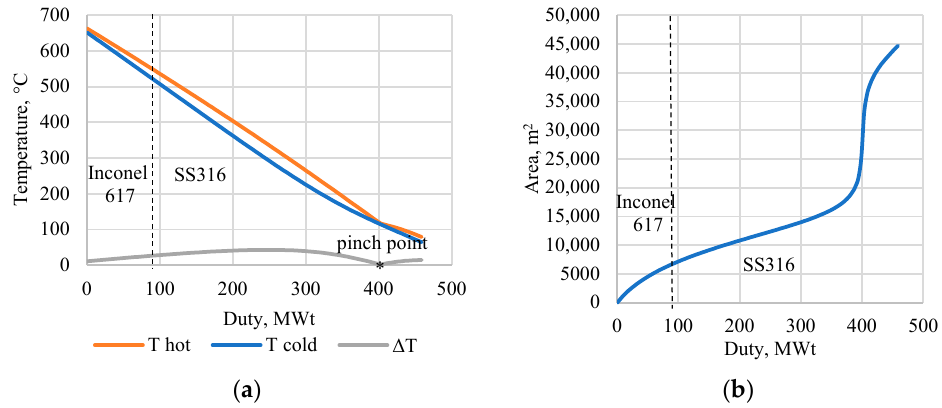
Figure 8. Regenerator diagram: ( a ) T-Q diagram; ( b ) area-duty diagram.